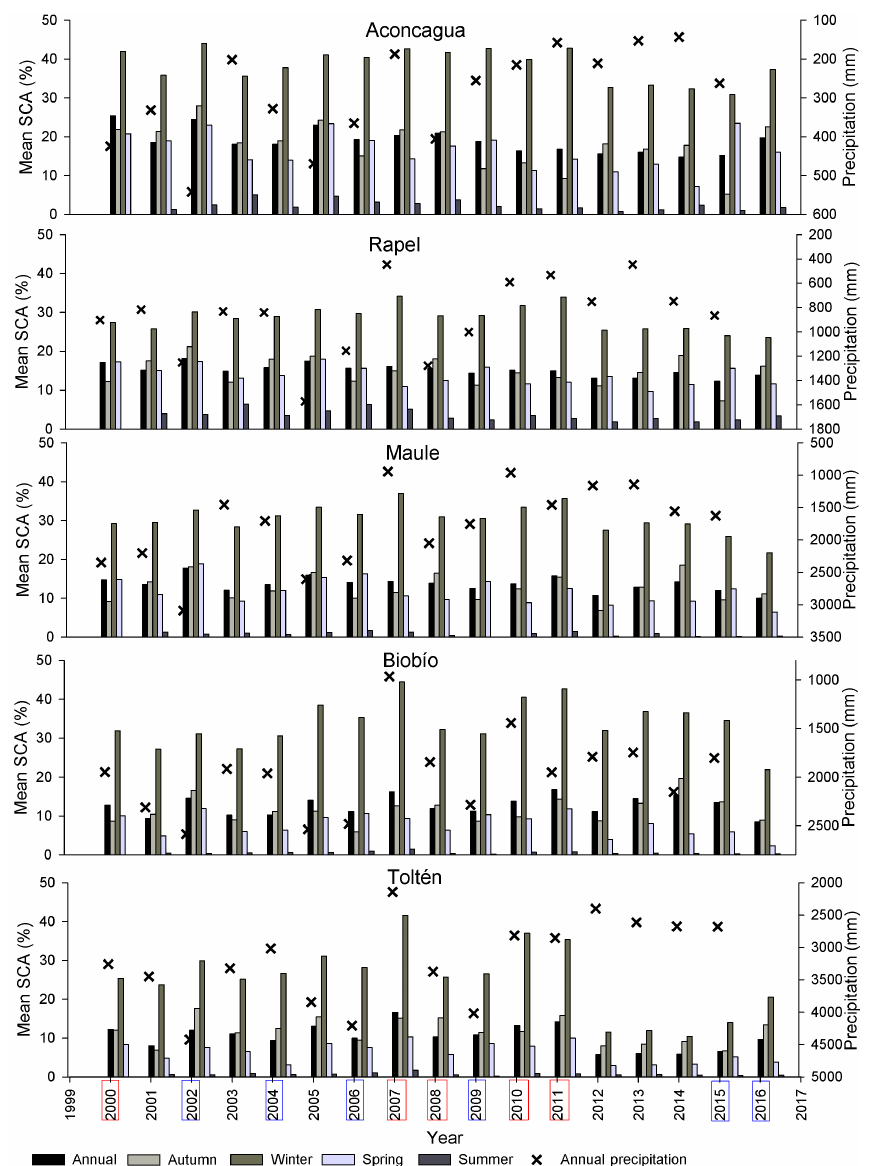
Figure 5. Mean seasonal and annual SCA (%) in Aconcagua, Rapel, Maule, Biobío and Toltén watersheds during 2000–2016. Red boxes indicate Niña years, blue ones Niño